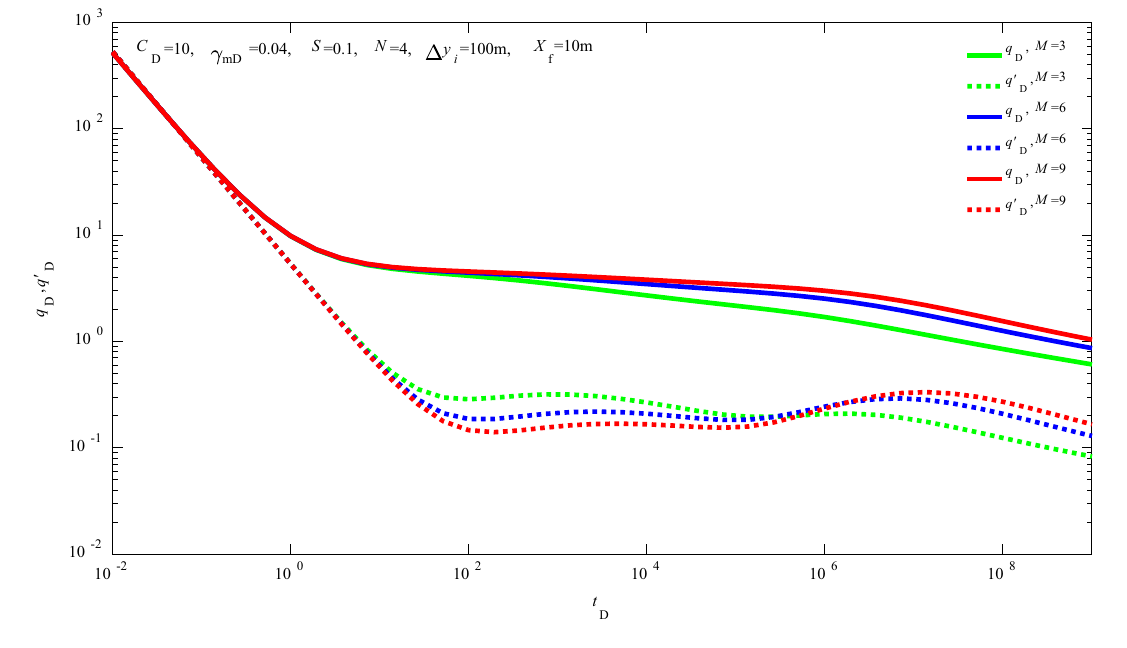
Fig. 9 Effect of fracture number on rate decline curves